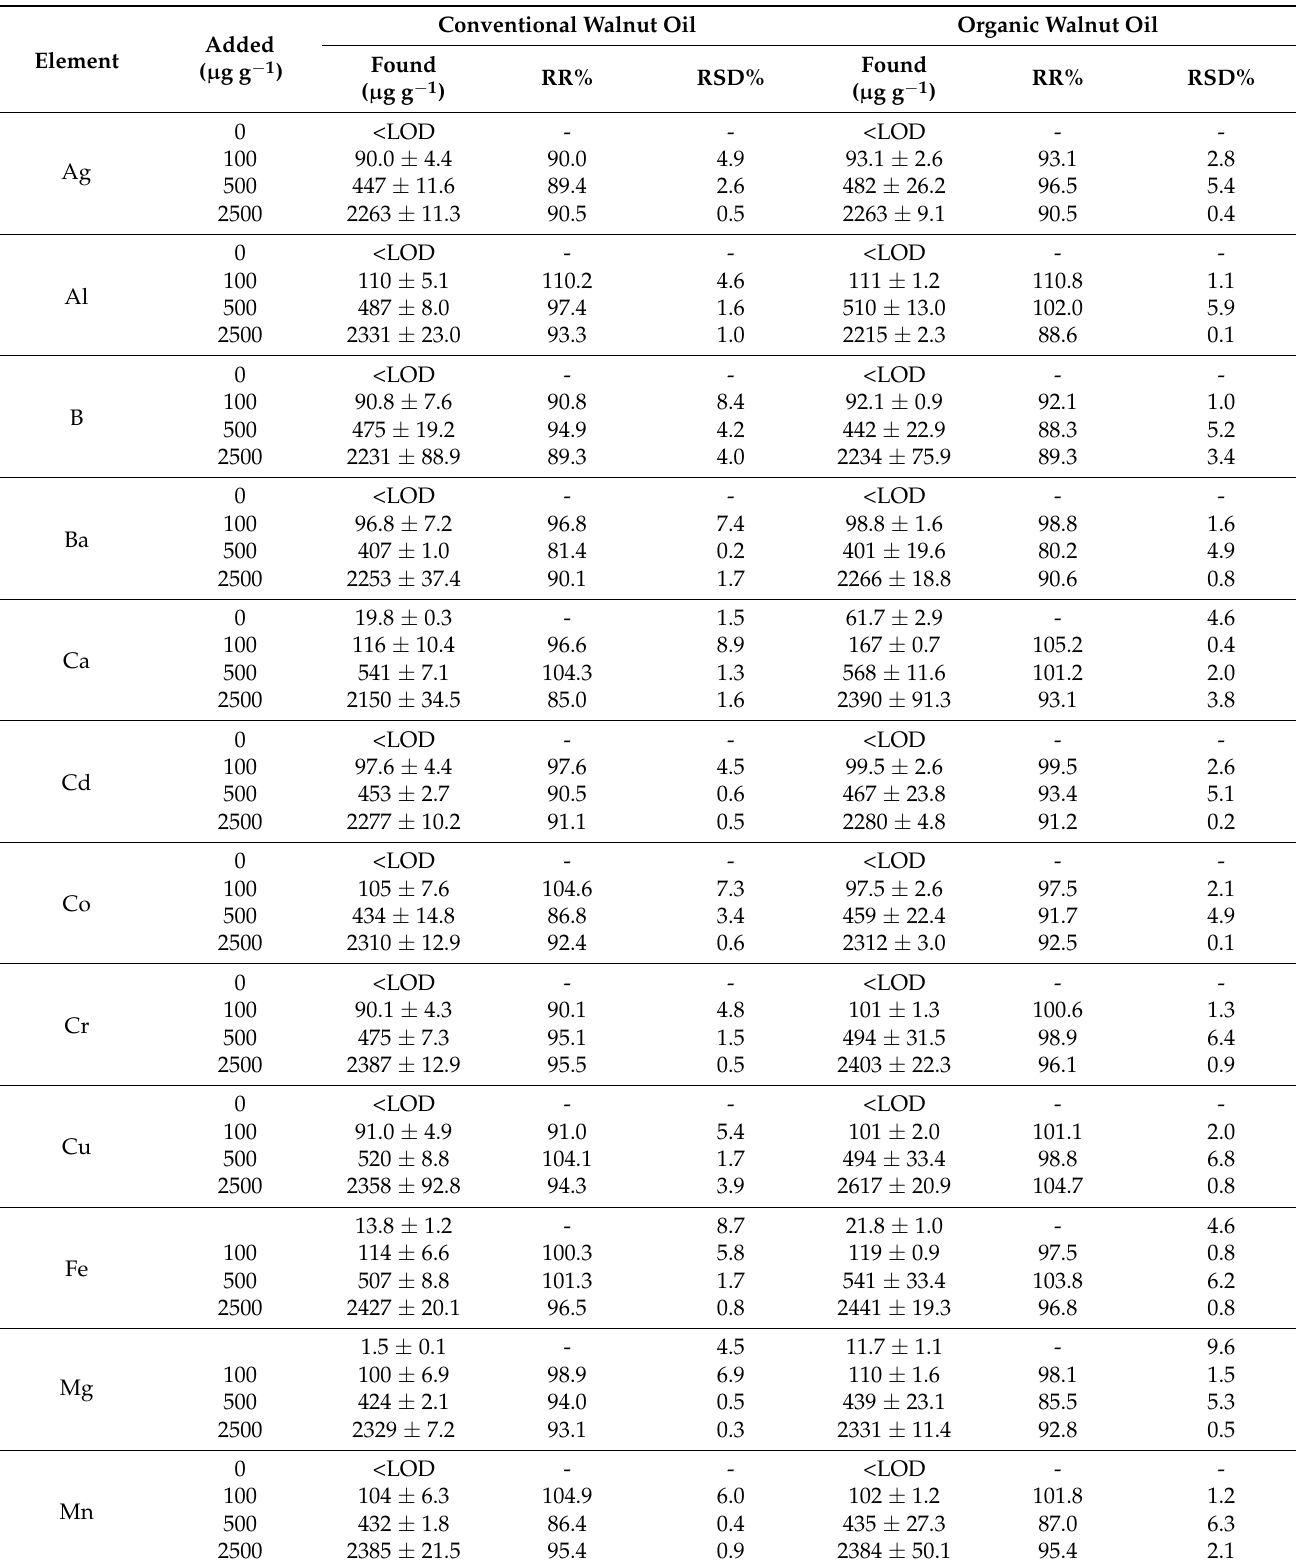
Table 3. Accuracy and precision results of the ICP-AES method (mean value ± standard deviation of five measurements).